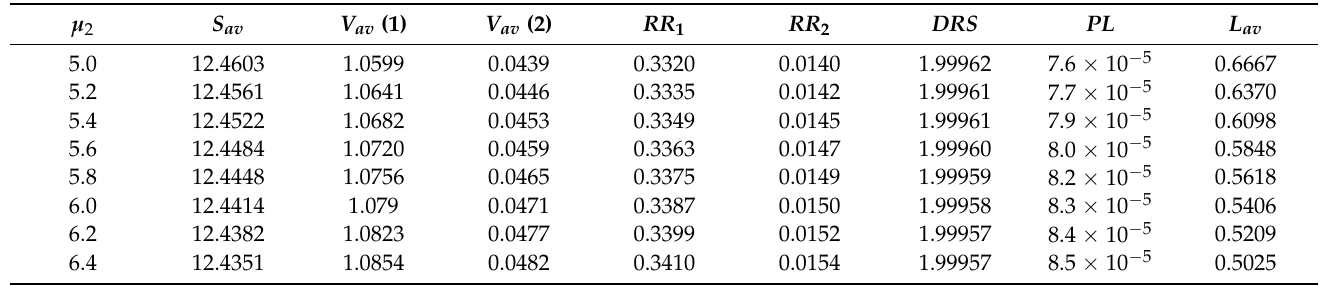
Table 3. Dependence of the performance measures on parameter µ 2 ; λ = 2, µ 1 = 5, κ = 2, τ = 2,